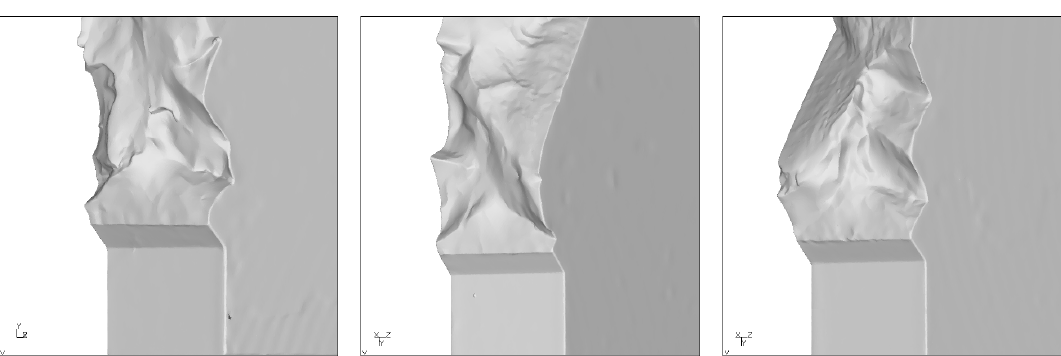
Figure 12. Three different experimental crack surfaces for loading conditions 1_1_90_1.